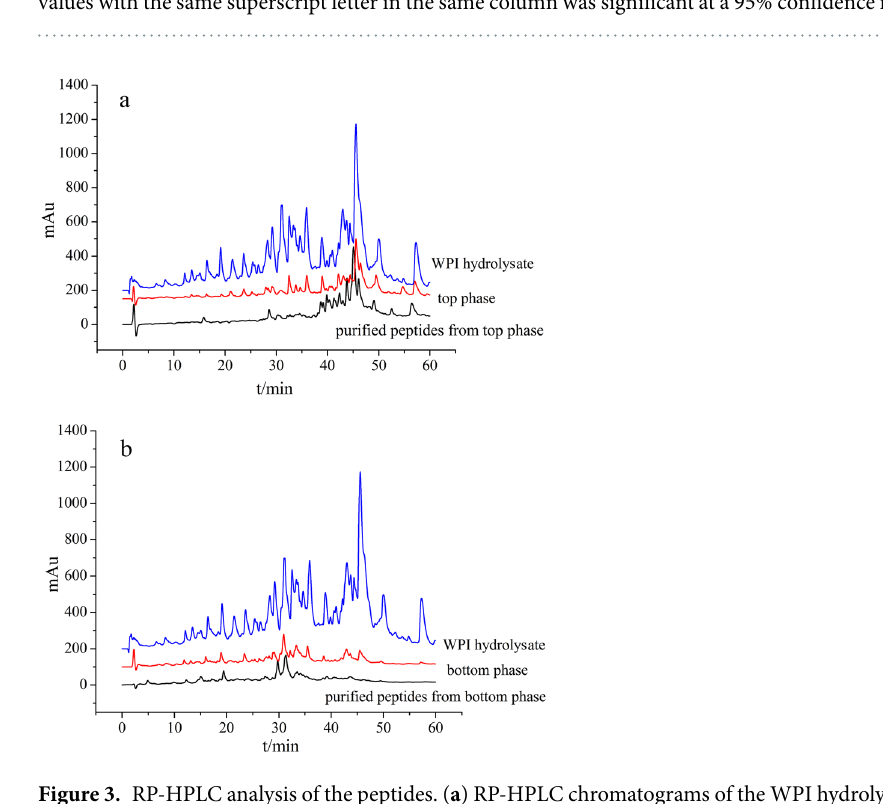
Figure 3. RP-HPLC analysis of the peptides. ( a ) RP-HPLC chromatograms of the WPI hydrolysate, top phase and purified peptides from the top phase, b: RP-HPLC chromatograms of the WPI hydrolysate, bottom phase and purified peptides from the bottom